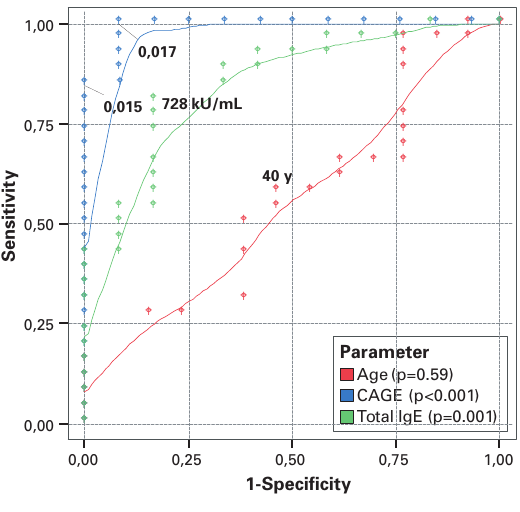
Receiver-operating characteristic (ROC) analyses to com- pare the composite atopy gene expression (CAGE) score, total IgE and age for diagnosing atopy. The CAGE score is a microarray-based diagnostic tool which allows to quantify atopy. It is composed of 10 disease-relevant genes which are differentially expressed in atopy and asthma. The CAGE score (area = 0.96 [0.90–1.00]; p <0.001) was better in differentiating atopic from non- atopic individuals than total IgE (area = 0.85 [0.73–0.98]; p = 0.001). The ROC curve for age fluctuated around the diagonal and was not significant (area = 0.50 [0.30–0.71]; p = 0.97). The dots show the relationship between sensi- tivity and specificity at the respective cut-off values. A smoothing iteration was performed to show continuous ROC curves